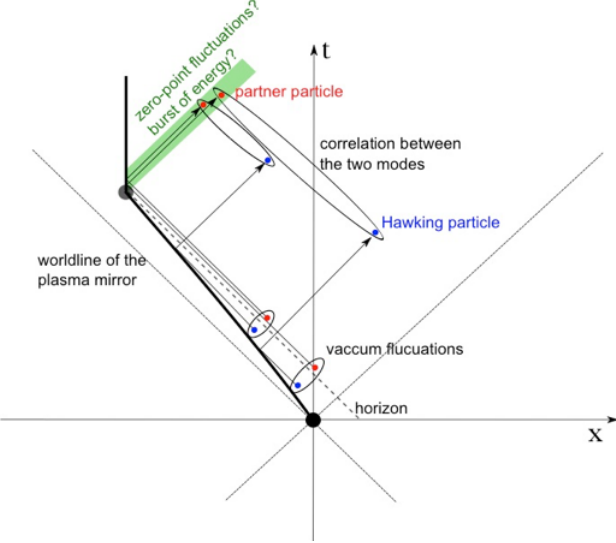
Figure 2. (Reproduced from Reference [25].) The ’worldline’ of an accelerating relativistic plasma mirror and its relation with vacuum fluctuations around the horizon. In particular, the entangle- ments between the Hawking particles (blue) emitted at early times and their partner particles (red) collected at late times are illustrated. The green strip represents either a burst of energy or zero-point fluctuations emitted when the acceleration stops